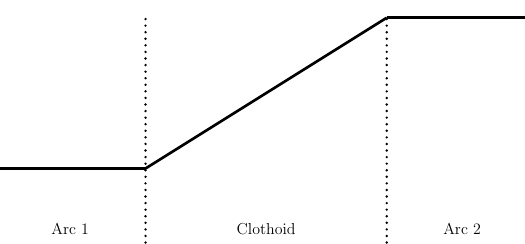
Figure11. Curvaturediagramofaclothoidconnectedtotwoarcsegmentsofdifferentradii. Figure 11. Curvature diagram of a clothoid connected to two arc segments of different radii.